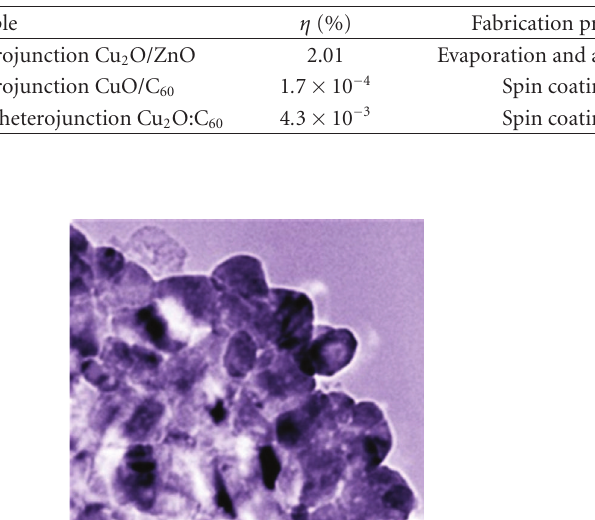
Table 2: Comparison of copper oxide-based solar cells.